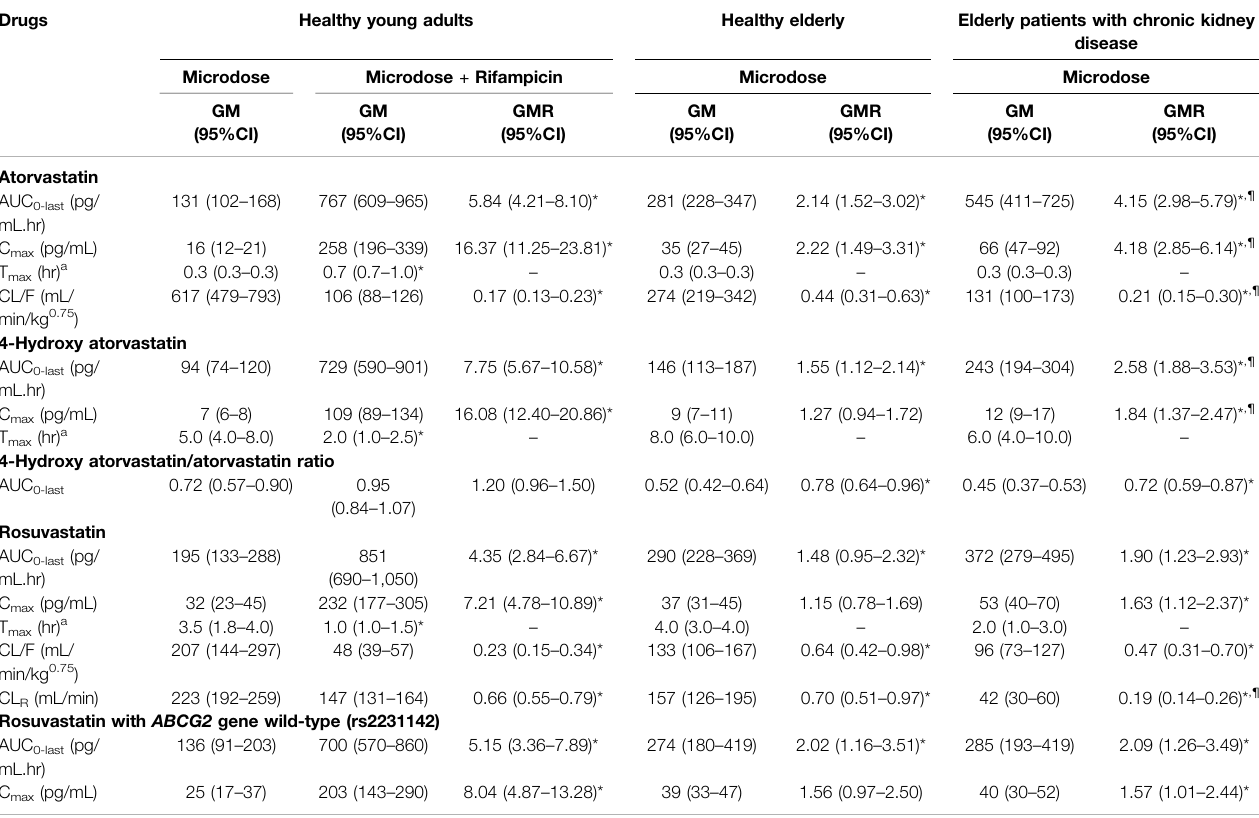
TABLE 4 | Pharmacokinetic parameters of atorvastatin, 4-hydroxy atorvastatin, rosuvastatin, and rosuvastatin with ABCG2 gene wild-type (rs2231142).